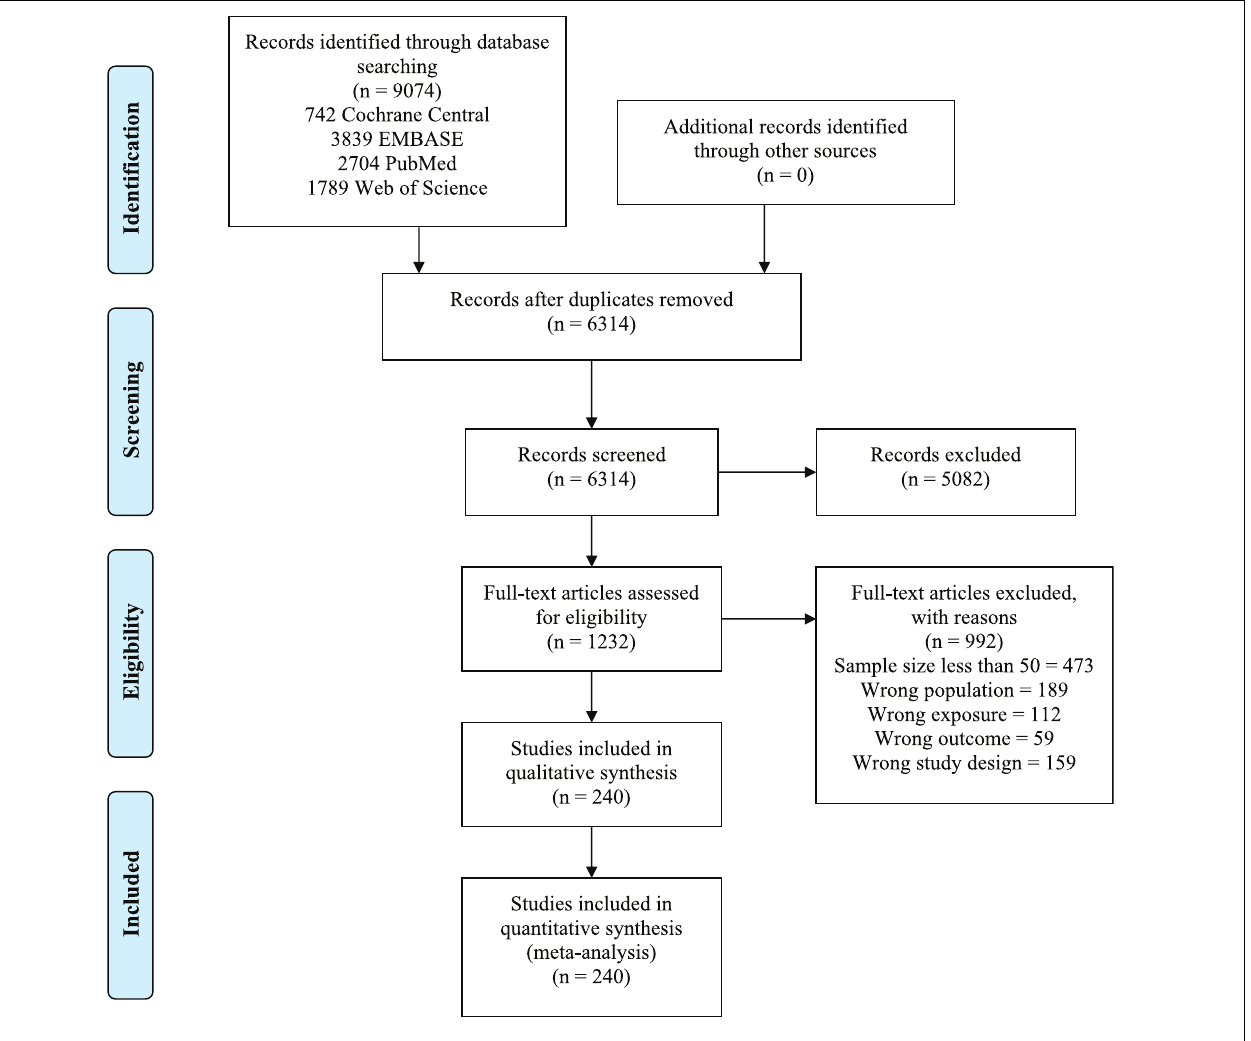
FIGURE 1 | PRISMA flow